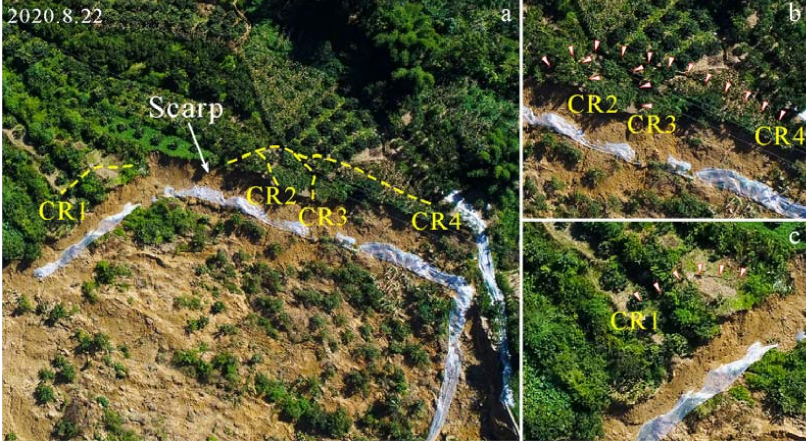
Figure 5. ( a – c ) The tension cracks observed at the headscarp after the landslide. “CR” is